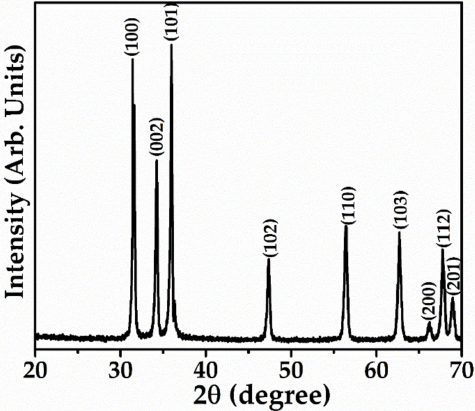
Figure 1. Typical XRD pattern of as-synthesized ZnO